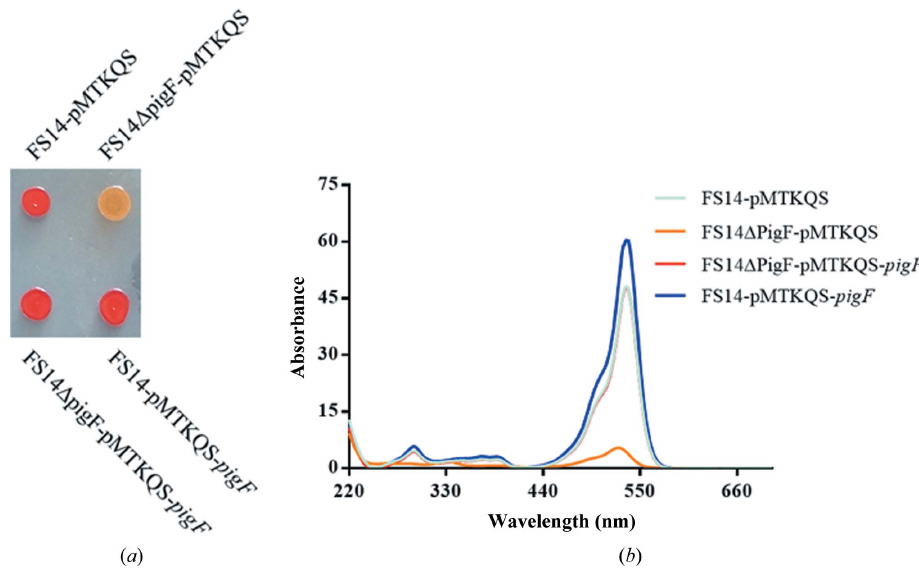
Figure 3 Absorption spectra of prodigiosin and norprodigiosin from FS14 and the FS14 (cid:2) PigF mutant. ( a ) The colour change of the products between FS14 and FS14 (cid:2) PigF. ( b ) The maximum absorption wavelength of prodigiosin from FS14-pMTKQS (cyan), the complementary strain FS14 (cid:2) PigF-pMTKQS- pigF (red) and the overexpression strain FS14-pMTKQS- pigF (blue) and of norprodigiosin from FS14 (cid:2) PigF-pMTKQS